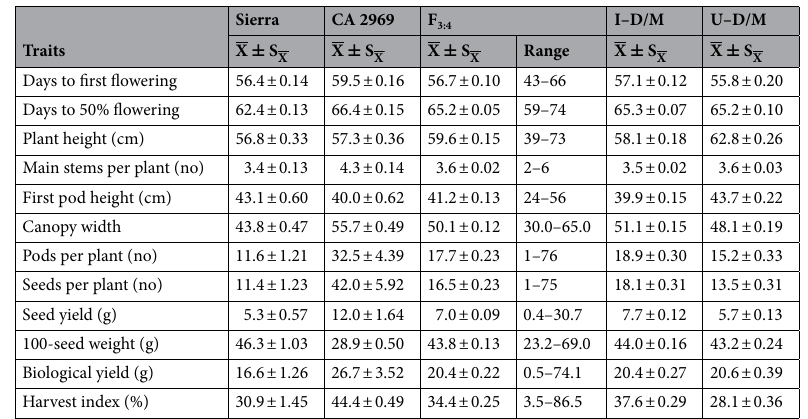
Table 3. Means ± standard errors and range for agro-morphological traits in F 3:4 superior lines having 100- seed weight ≥ 45 g and double/multi-podded selected in F 3 . I–D/M: imparipinnate-leafed anddouble/multi- podded progeny, U–D/M: unifoliolate-leafed and double/multi-podded